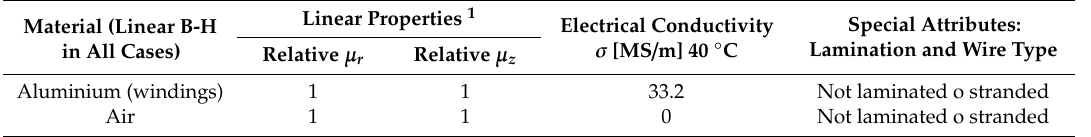
Table 6. Magnetic simulation: Material properties.